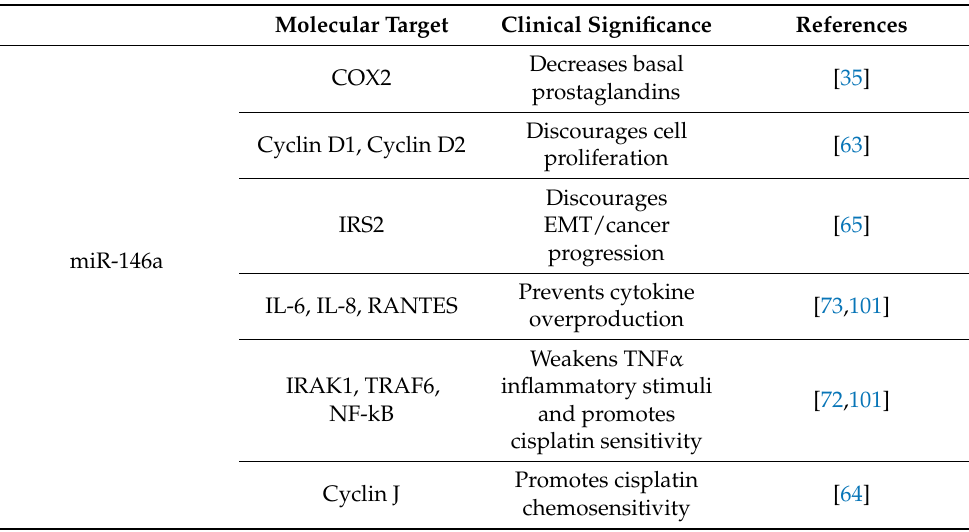
Table 1. Experimentally validated targets of miR-146a in lung